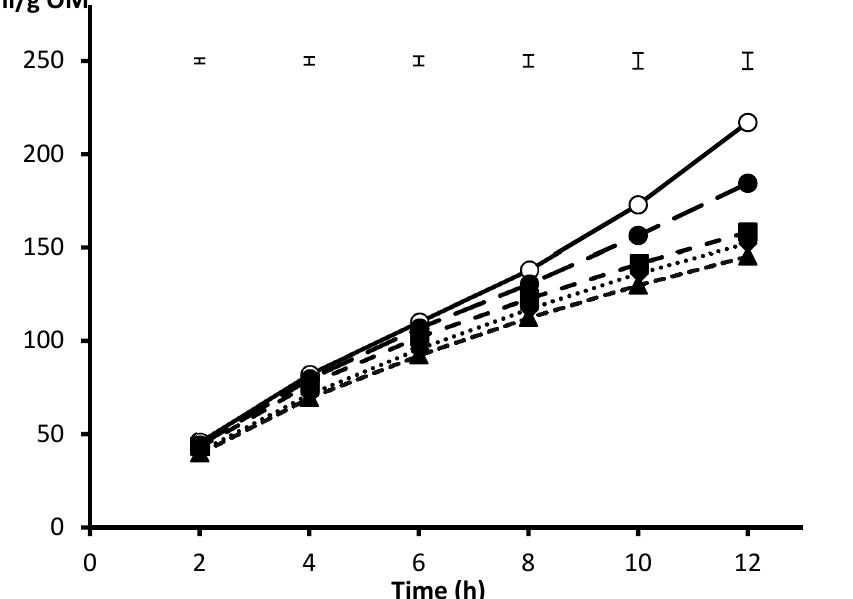
Figure 2. Gas production pattern from barley incubated in media buffered to 6.5 ( ), 6.25 ( ), 6.00 ( ), 5.75 ( ) and 5.50 ( ). From Amanzougarene and Fondevila [40].